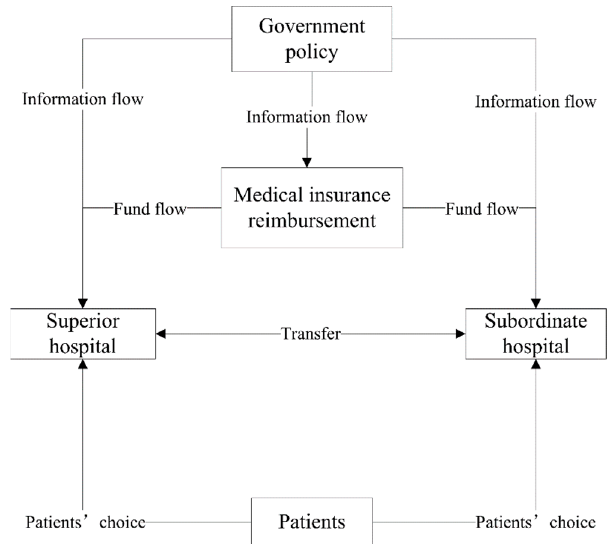
Figure 1. Healthcare supply chain network.